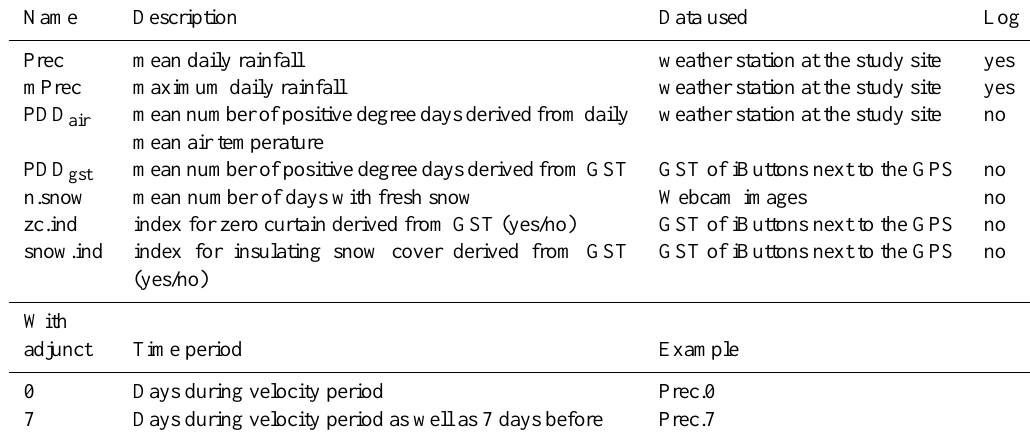
Table 3. Overview of potential explanatory variables used. As potentially important time periods, we used days during the peak, also including the total of days during the peak and 7 days before the peak. For precipitation for the logistic regression models, a log transformation was applied